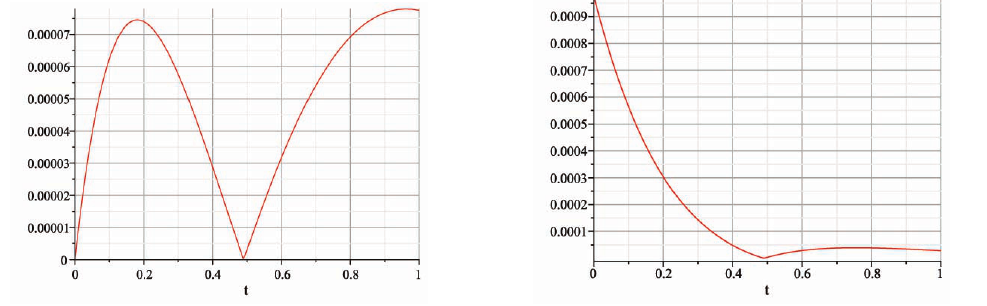
Figure 3: Plot of the | y ( t ) − y